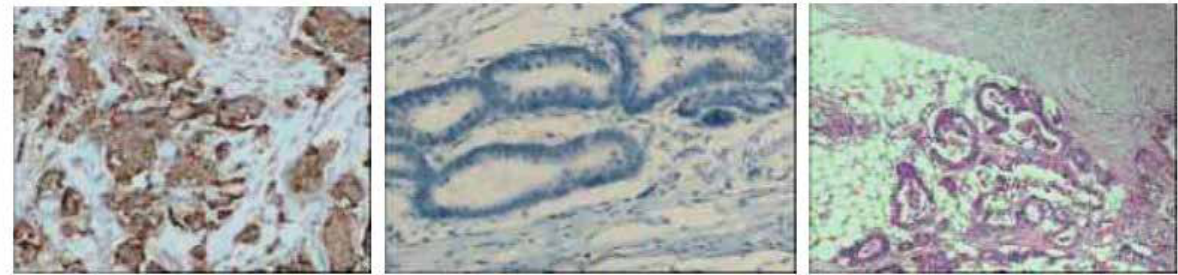
Figure 2: A. Neogenin Positive (×100); B Negative stain control (×100) C H&E (×100)